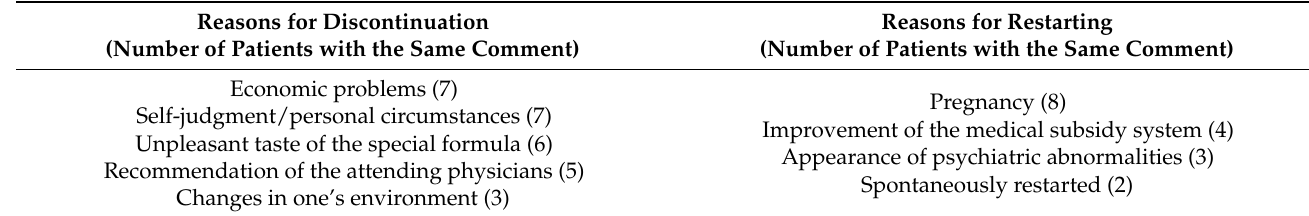
Table 2. Reasons for discontinuing or restarting dietary